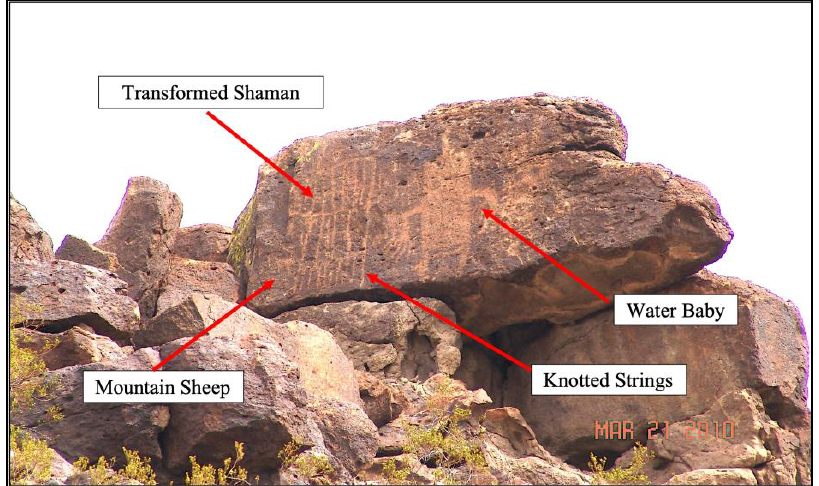
Figure 9. Analysis of shaman and water baby patterns from Black Butte (Source: